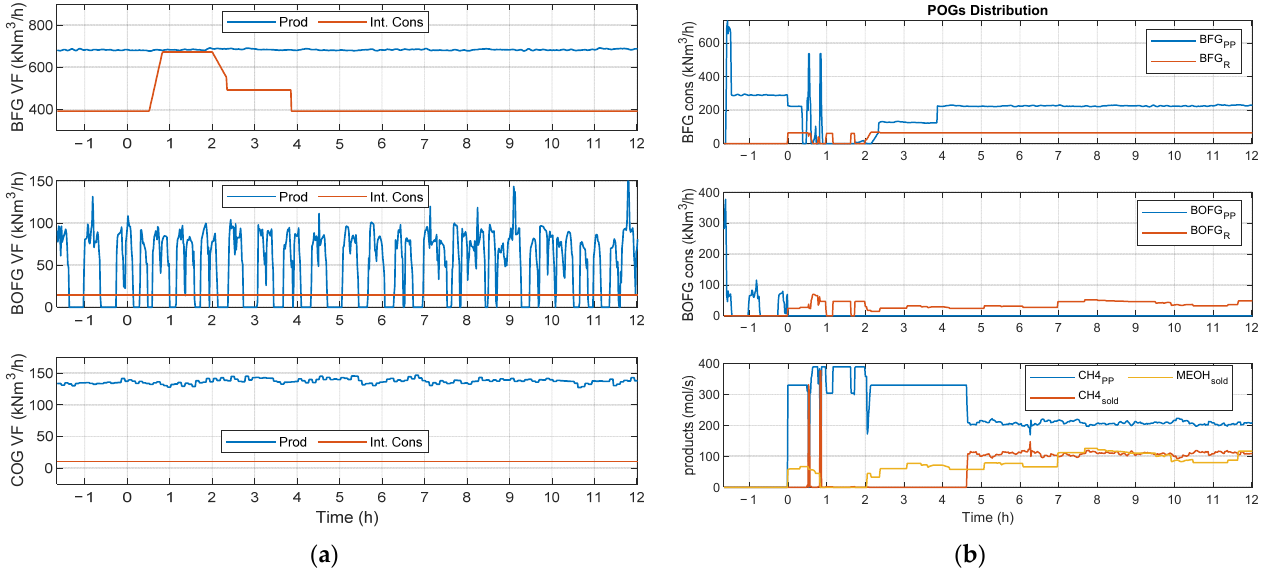
Figure 11. SC2. ( a ) POG production and consumption by internal users; ( b ) POG distribution to PP and methane reactors, methane consumption in PP and sent to market, and methanol sold.